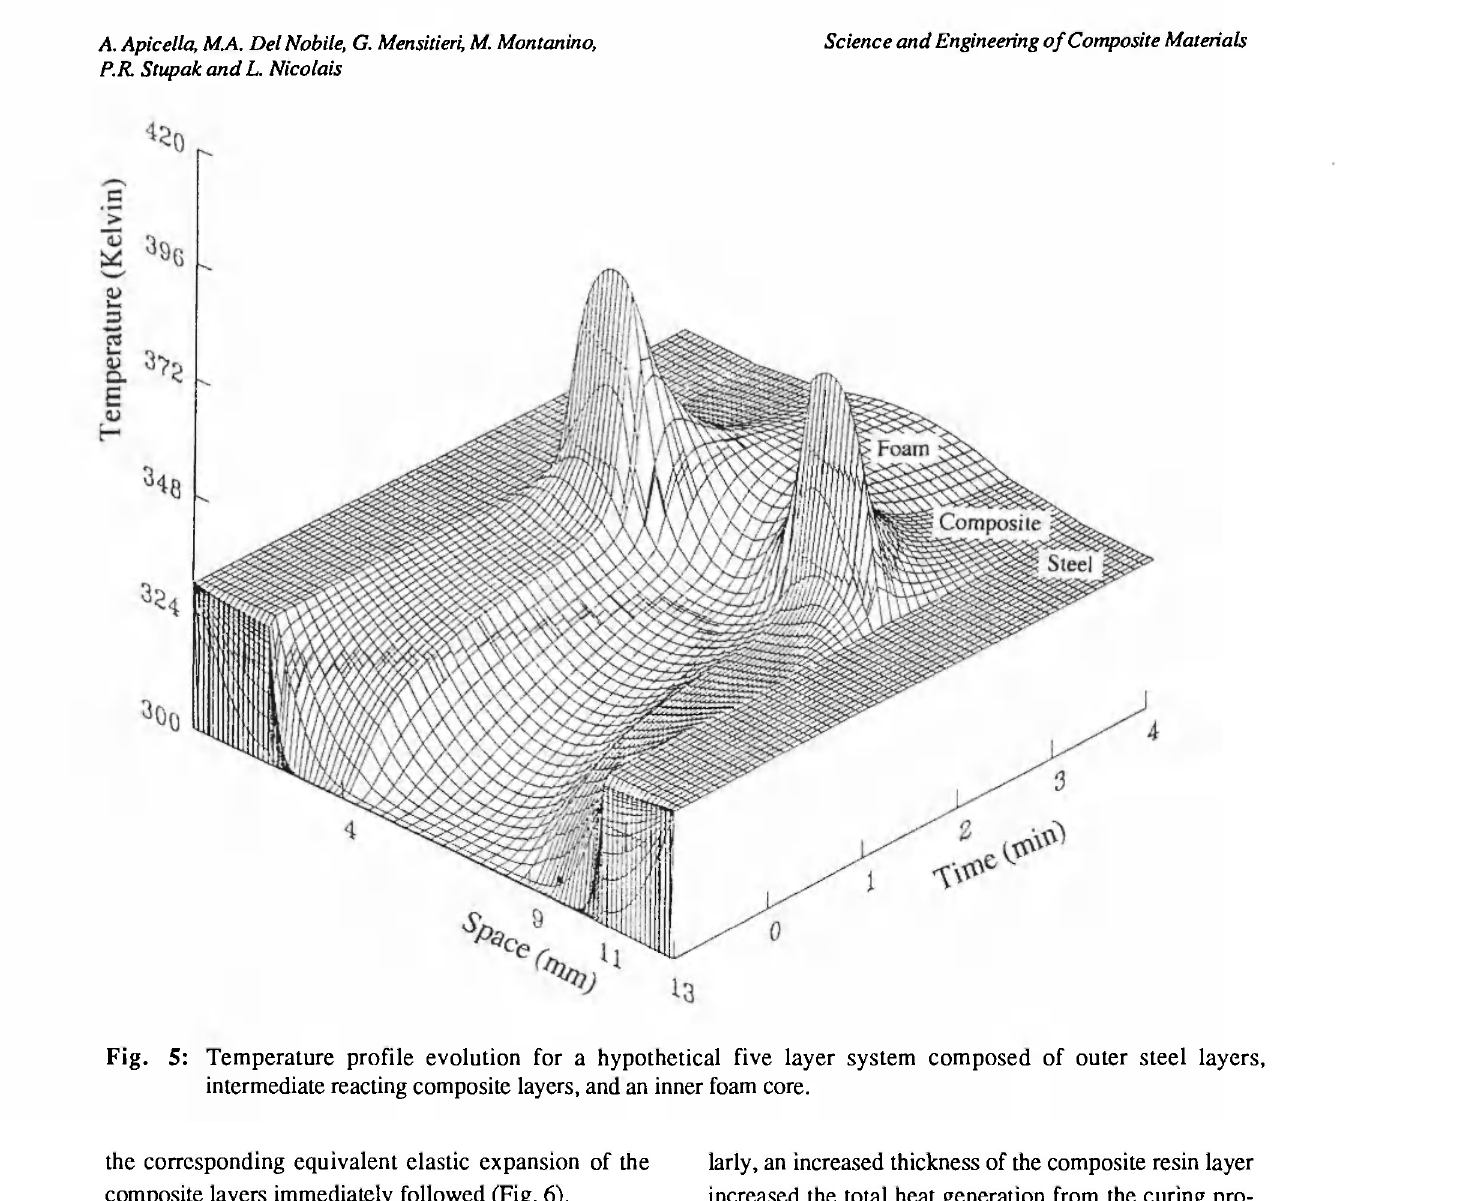
5: Temperature profile evolution for a hypothetical five layer system composed of outer steel layers, intermediate reacting composite layers, and an inner foam core.